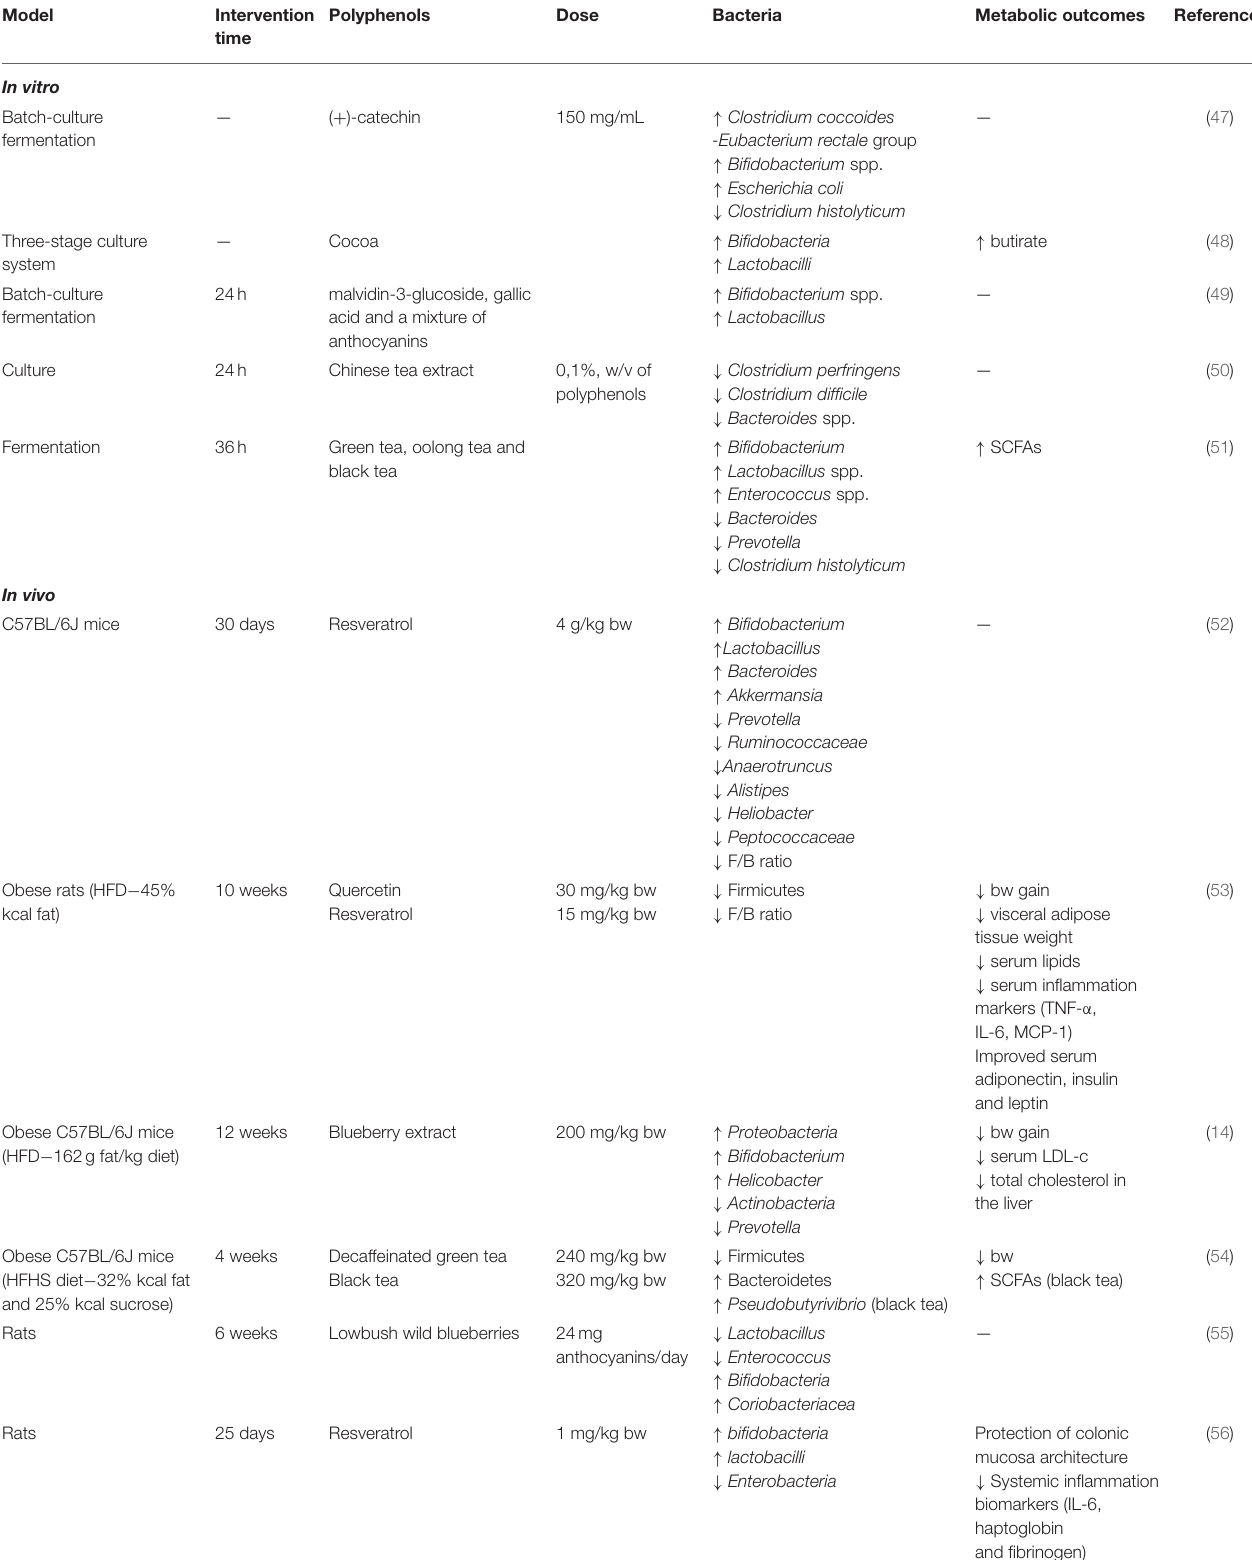
TABLE 3 | Summary of the main findings of studies related to the effects of polyphenols on gut microbiota and metabolic outcomes.